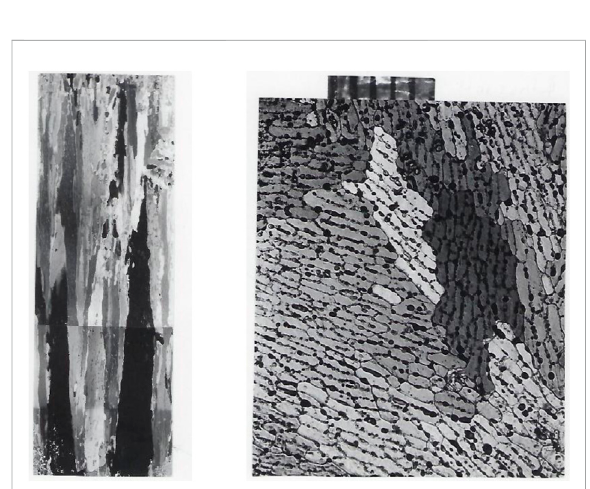
FIGURE 4 Thin section of sea ice along the vertical direction (17.5 cm long) and horizontal direction (16 cm on a side). Markers at top of the horizontal section are 1 mm. Individual vertical crystals are made visible by observation under polarized light. Small brine pockets appear along grain boundaries in the horizontal section (Photo courtesy of A. Gow and K.